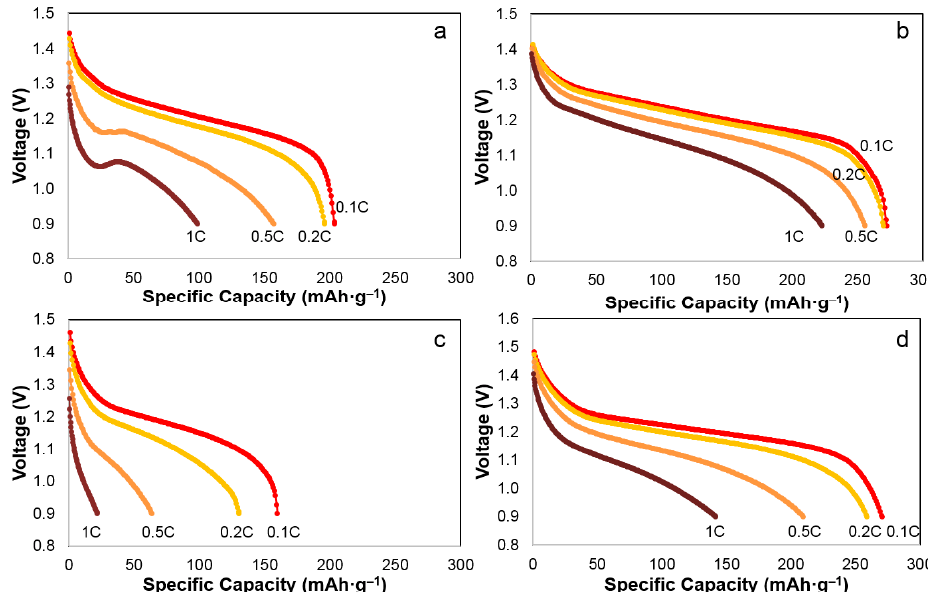
Figure 6. Discharge rate evaluation by measuring the discharge capacities of ( a ) Cell AP50 and ( b ) Cell WM12 at room temperature and ( c ) Cell AP50 and ( d ) Cell WM12 at − 10 °C. All o the measurements were charged at 0.1C. Table 5. Discharge capacities at different rates for Cells AP50 and WM12 at both room temperature (RT) and − 10 °C.